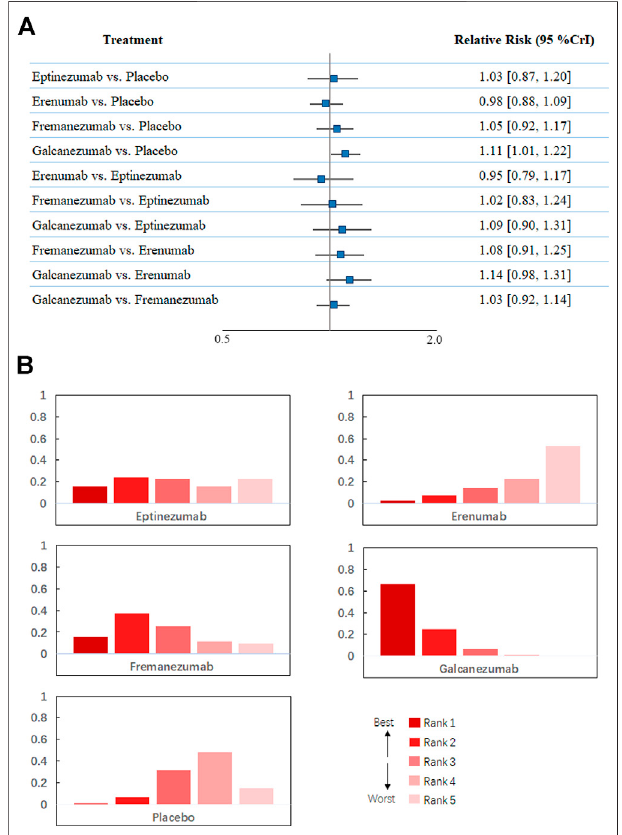
FIGURE 4 | (A) . Network meta-analysis of treatment-emerging adverse events. (B) . Ranking positions of different drugs in treatment-emerging adverse events. CrI: credible